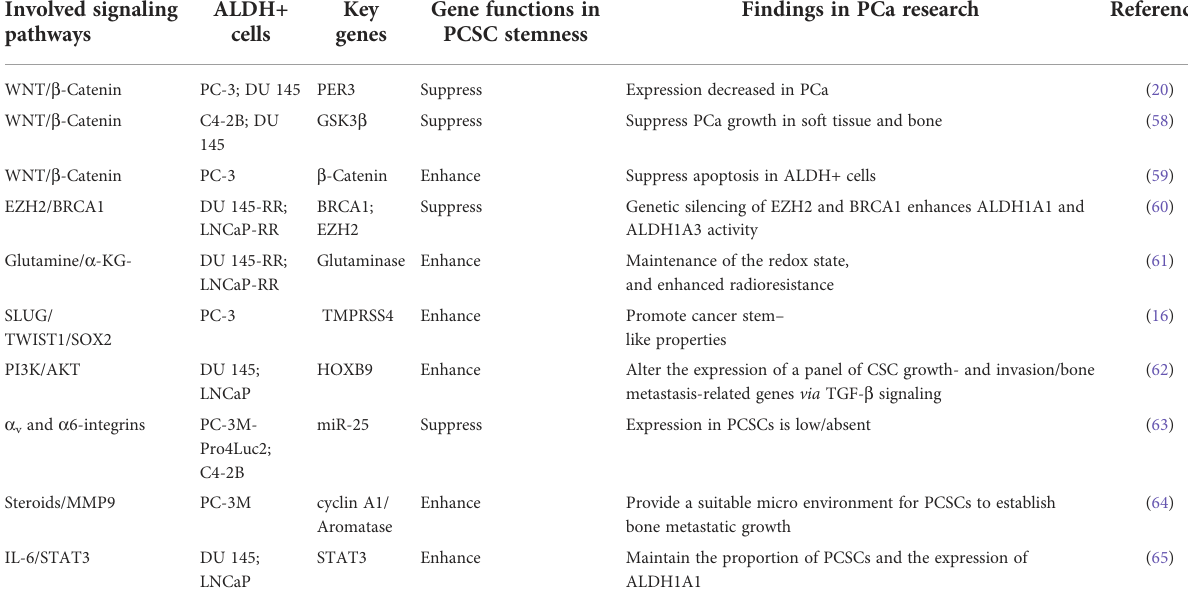
TABLE 1 Crucial signaling pathways that regulate ALDH+ cells in prostate cancer. Involved signaling